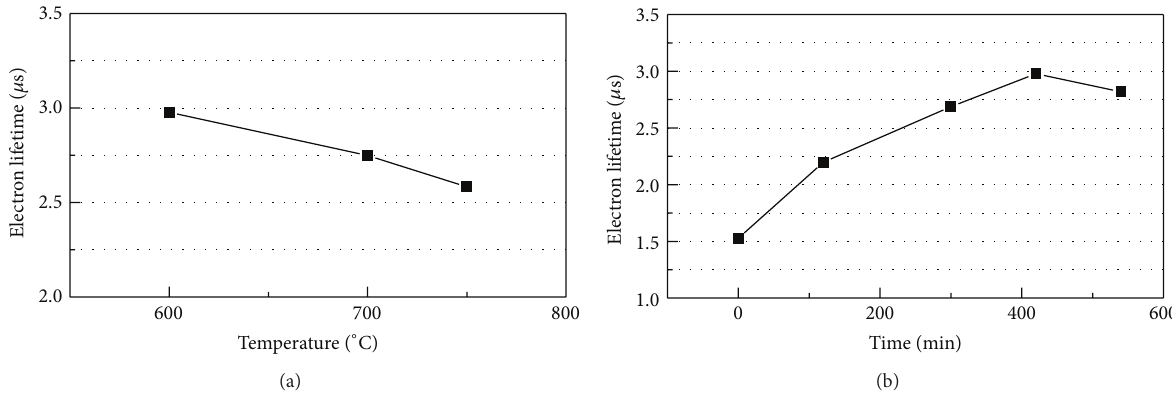
Figure 6: Electron lifetime of the UMG-Si wafer processed with two-step gettering. The first step of the temperature profile was fixed to 850 ∘ C and 50min, and during the second step (a) the temperature and (b) the time were varied. The highest electron lifetime was obtained at 600 ∘ C for 420 min.